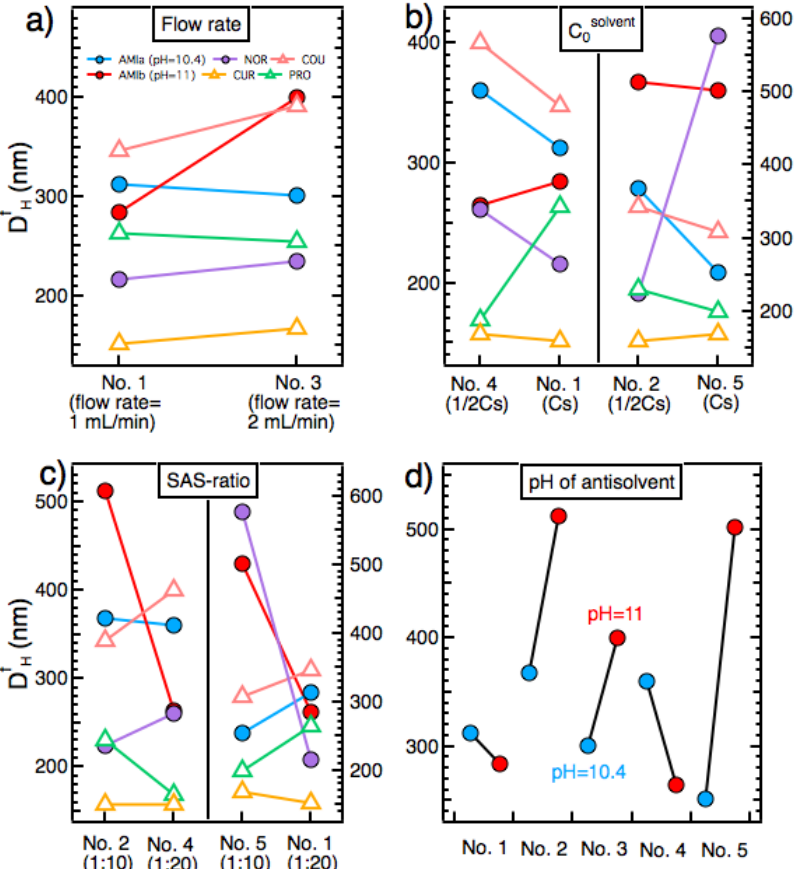
Figure 5. The effects of ( a ) flow rate, ( b ) compound concentration in the solvent solution 𝐶 0𝑠𝑜𝑙𝑣𝑒𝑛𝑡 , ( c ) SAS-ratio (for AMIa, COU, CUR, NOR and PRO), and ( d ) pH of the antisolvent (for AMI particles prepared by protocols No.1–No.5; Table 2) on the final particle size 𝐷 𝐻𝑓 . All subfigures share the legend provided in ( a ).